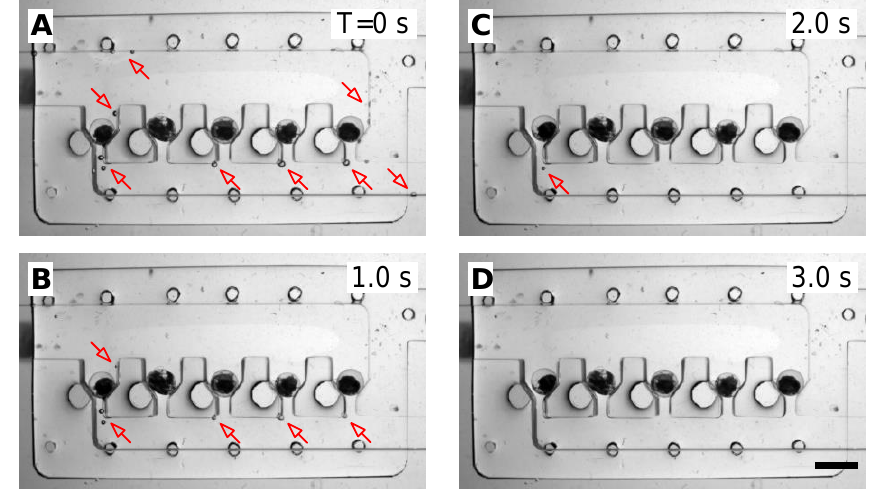
Figure 4. Fast evacuation of air bubbles (indicated by arrows) in the embryo-culturing channel within 3 s. ( A ) T = 0 s; ( B ) T = 1.0 s; ( C ) T = 2.0 s; ( D ) T = 3.0 s. Scale bar: 2 mm.